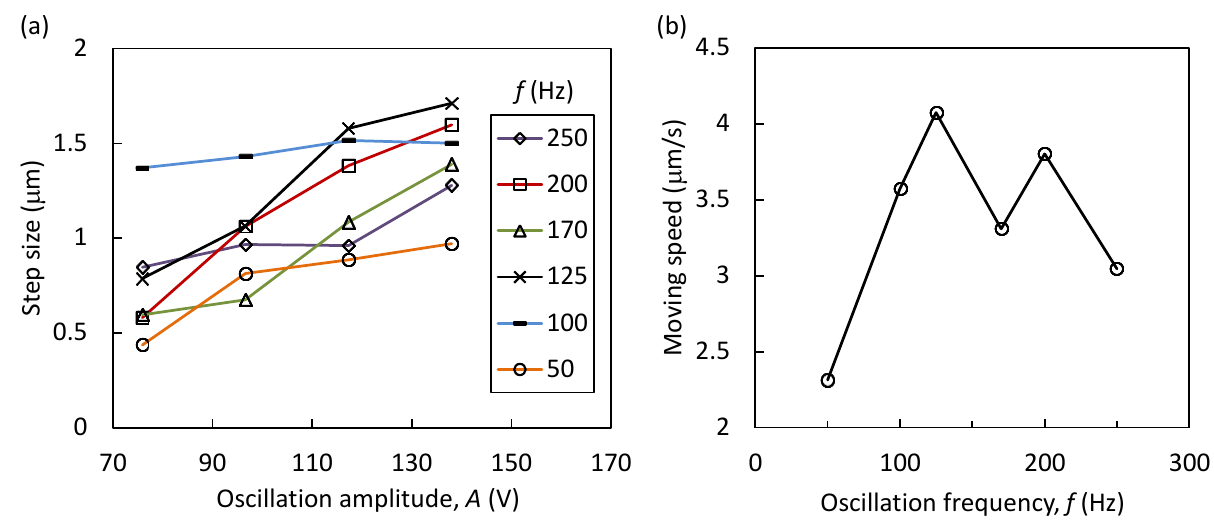
Figure 4. ( a ) The variation of the step size versus the oscillation amplitude at various oscillation frequencies. ( b ) The variation of the moving speed versus the oscillation frequency at an A value of 138